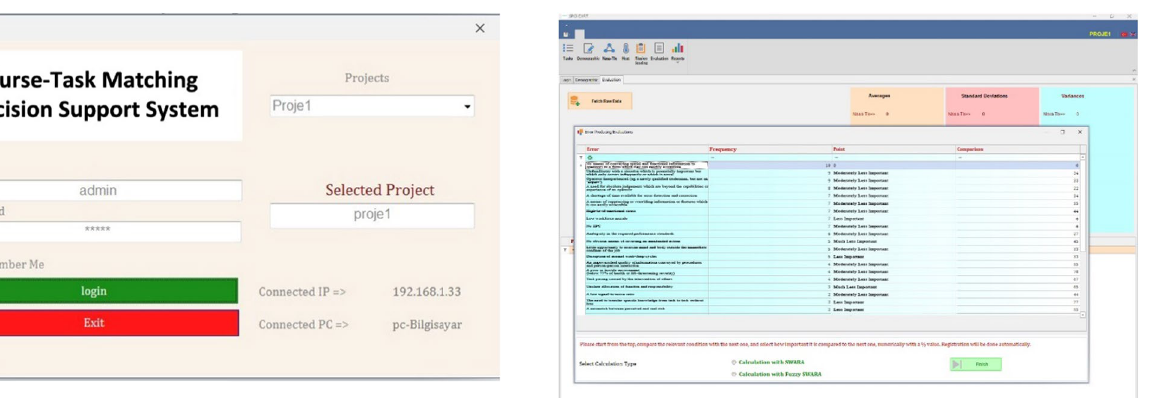
Fig. 7 SWARA and FSWARA calculation screen